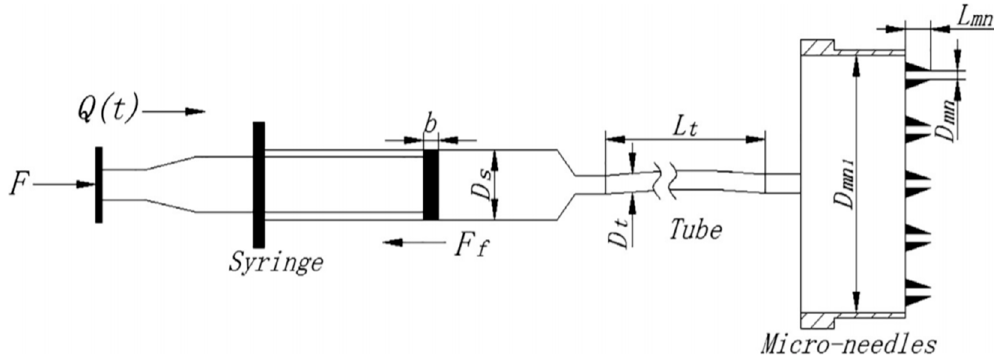
Figure 17. Physical model of syringe driven MN delivery system (adopted from [129]).